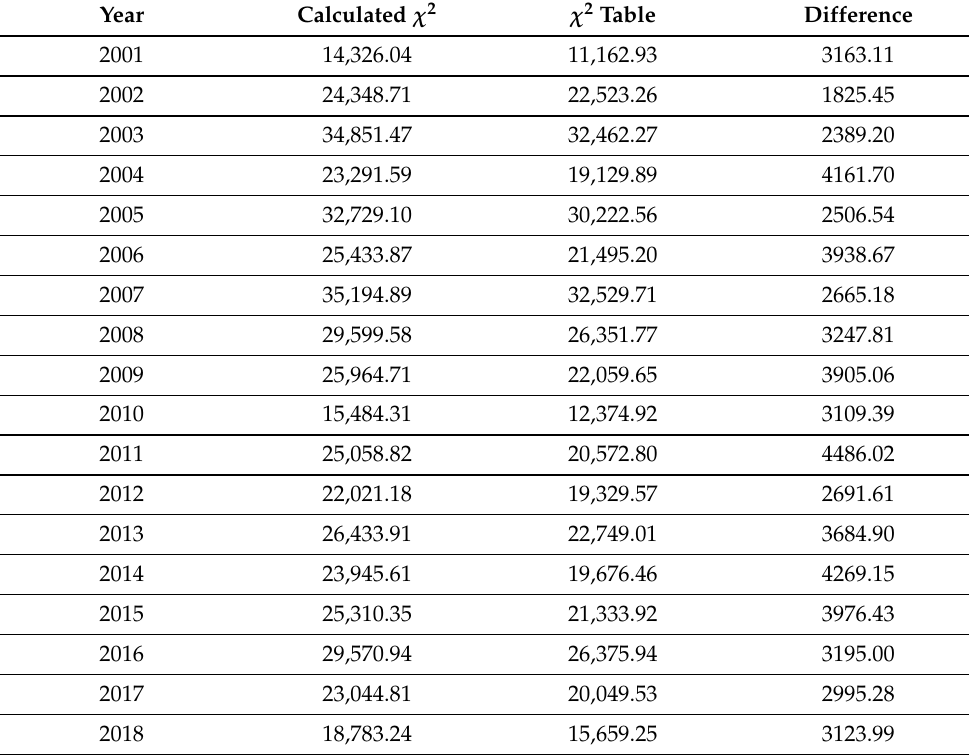
Table A1. Results of calculated Chi2 or χ 2 , and Table showing χ 2 values from 2001 to 2018.